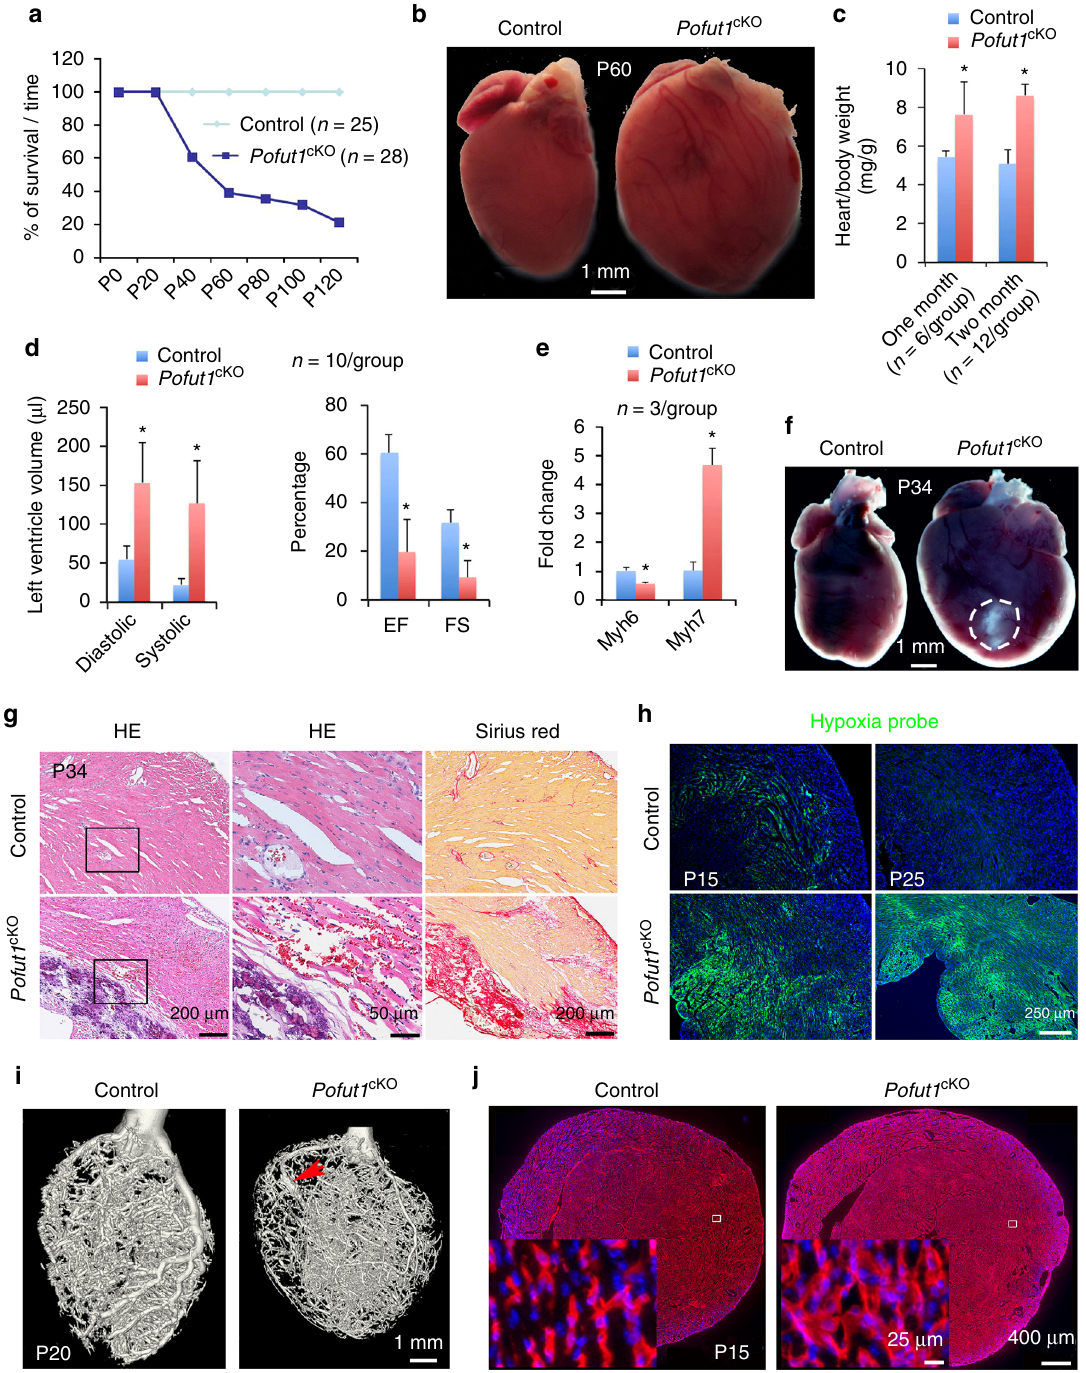
Fig. 1 Loss of Pofut1 causes coronary artery anomalies and ischemic heart disease. a Survival curve shows ~80% Nfatc1 Cre ;Pofut1 f/f ( Pofut1 cKO ) mice die by P120. b Gross view of a dilated P60 Pofut1 cKO heart. c Heart/body ratio. * p < 0.01. d Echocardiography showing reduced cardiac functions in P60 Pofut1 cKO heart. * p < 0.001. e qPCR showing reversed expression changes of Myh6 and Myh7 in P21 Pofut1 cKO hearts. * p < 0.01. f Gross view of a large myocardial infarct ( circle ) at the apex of a P34 Pofut1 cKO heart. g Cardiac histology showing cardiac necrosis and fi brosis in a P34 Pofut1 cKO heart. h Hypoxia staining showing expansion of inner myocardial hypoxia in young Pofut1 cKO mice. i MicroCT shows coronary anomalies with hypoplastic main arteries and aneurisms ( arrow ). j PECAM1 staining shows increased primitive coronary plexuses in a P15 Pofut1 cKO heart. All bar charts represent mean ±